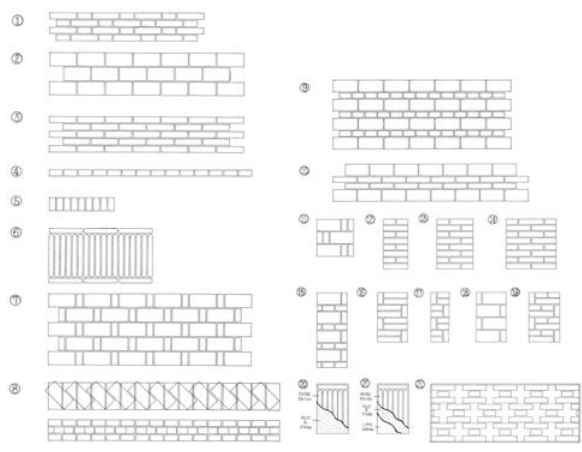
Figure 10. Patterns of